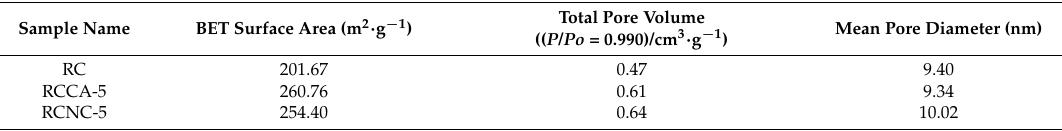
Table 3. Specific surface, total pore volume, and mean pore diameter of composites after Cd 2+ adsorption at pH 6, and 50 ppm